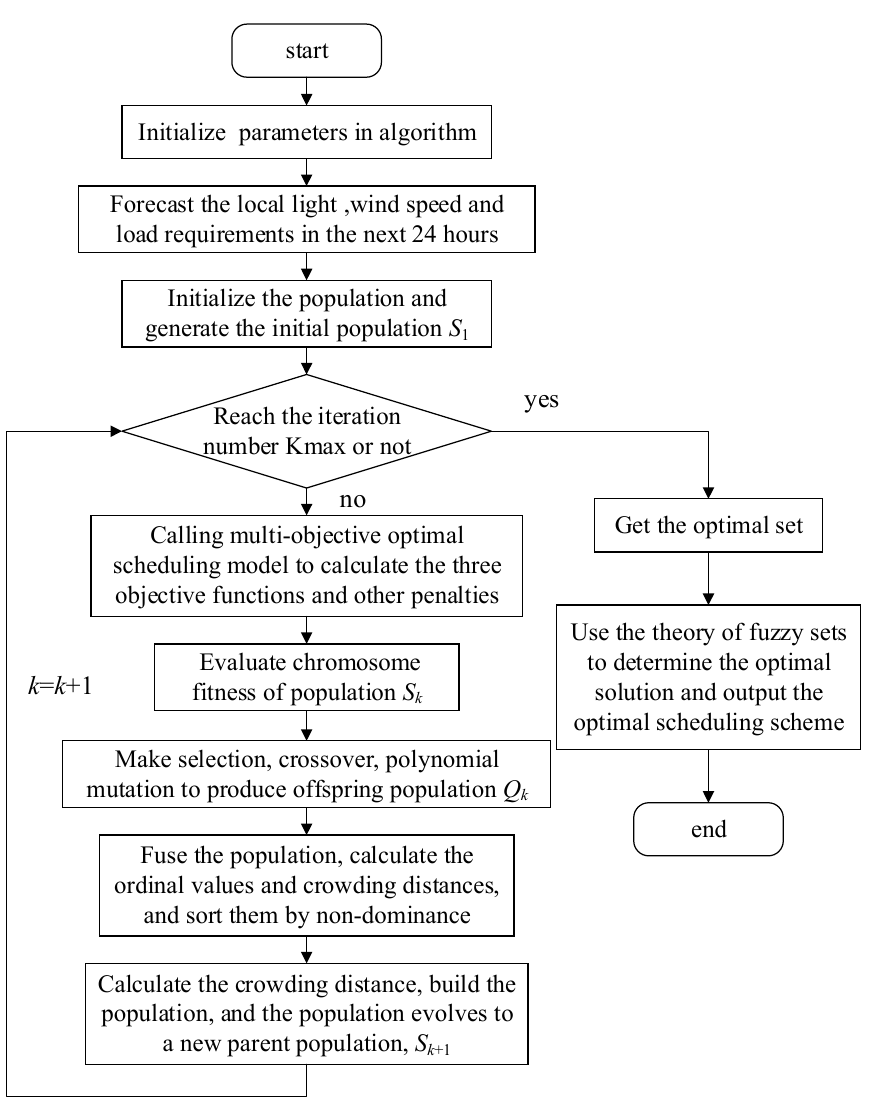
Figure 3. The flow chart based on a variant of the NSGA- Ⅱ algorithm. In the flow chart, k is the iteration number; Kmax, S 1 , S k and Q k are the maximum iteration number, the initial population, the population in the k-generation and the k-off- spring-generation population,